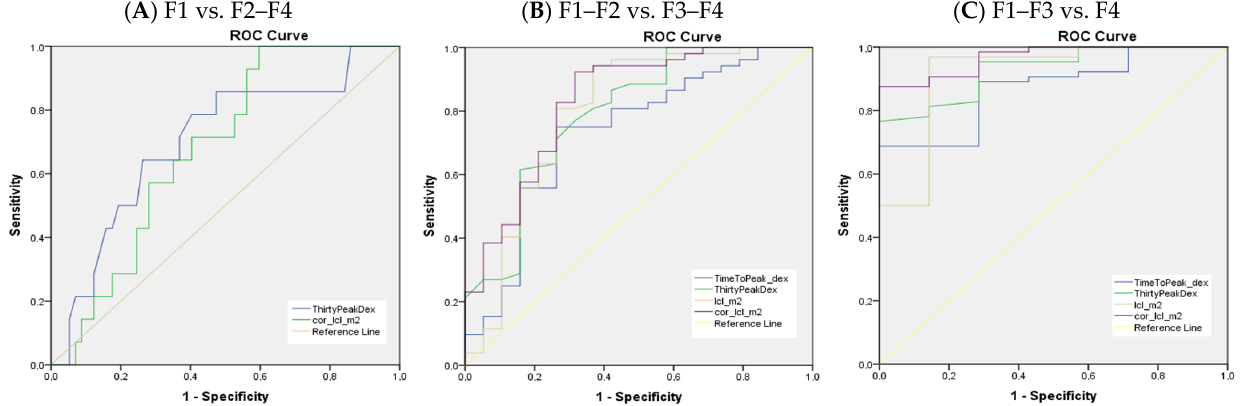
Figure 3. AUROC for most significant parameters discriminating liver fibrosis stages. ThirtyPeakDex–30/peak ratio in the right lobe. cor_lcl_m2–LCL_m 2 _dm 2 (liver clearance corrected for BSA and LA). TimeToPeak_dex–TTP_dex.